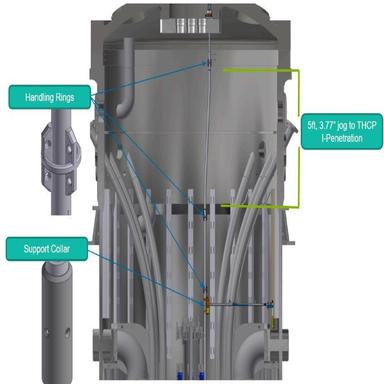
A break-out view of the IMPACT experiment leadout section installed in ATR. THCP-MkII seal hardware seals the experiment through the top of the reactor, handling rings are used for installation, and the support collar interfaces with the LSA.